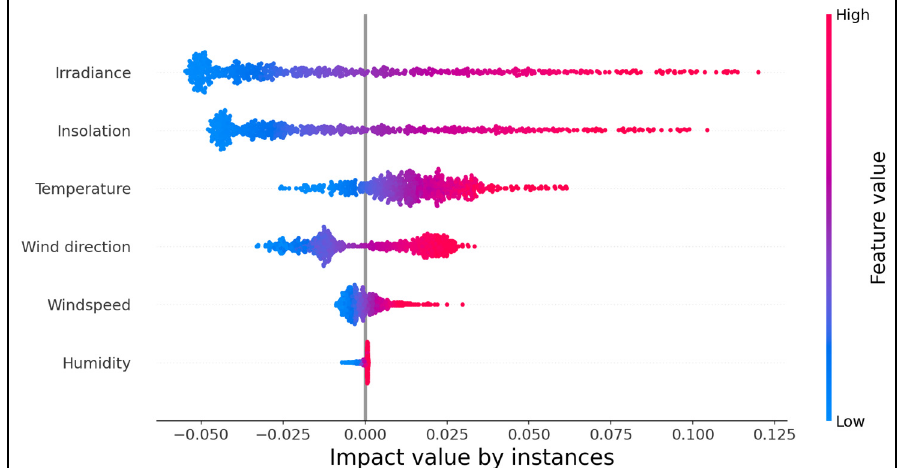
Figure 9. Feature impact by instance of the test dataset on model’s performance.